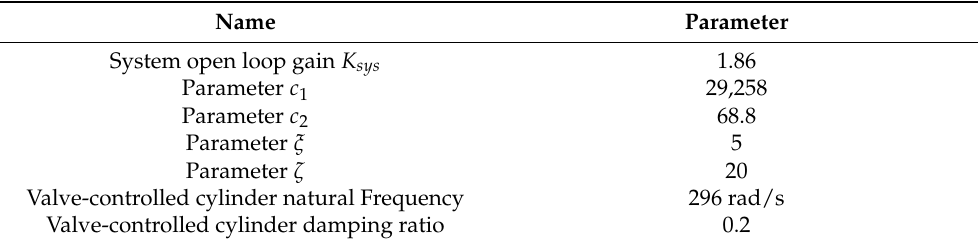
Table 2. Parameters of adaptive reaching law SMC algorithm.